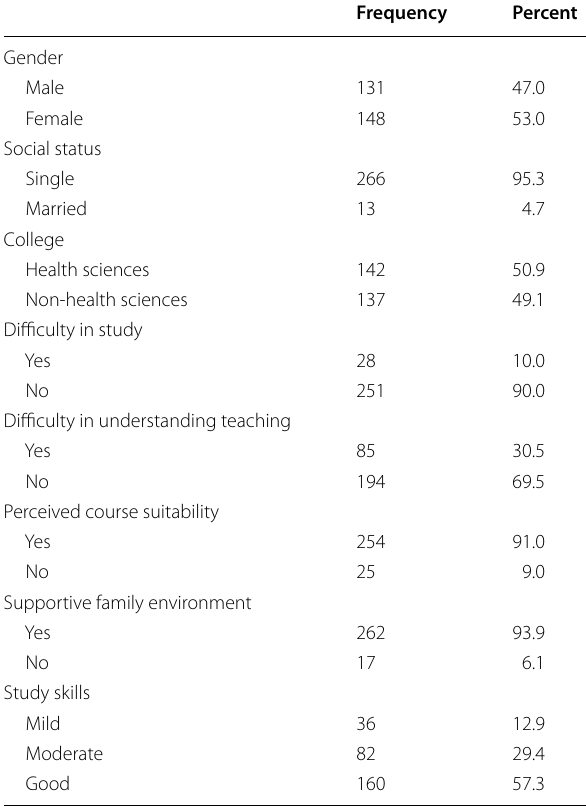
Table 1 Sociodemographic features